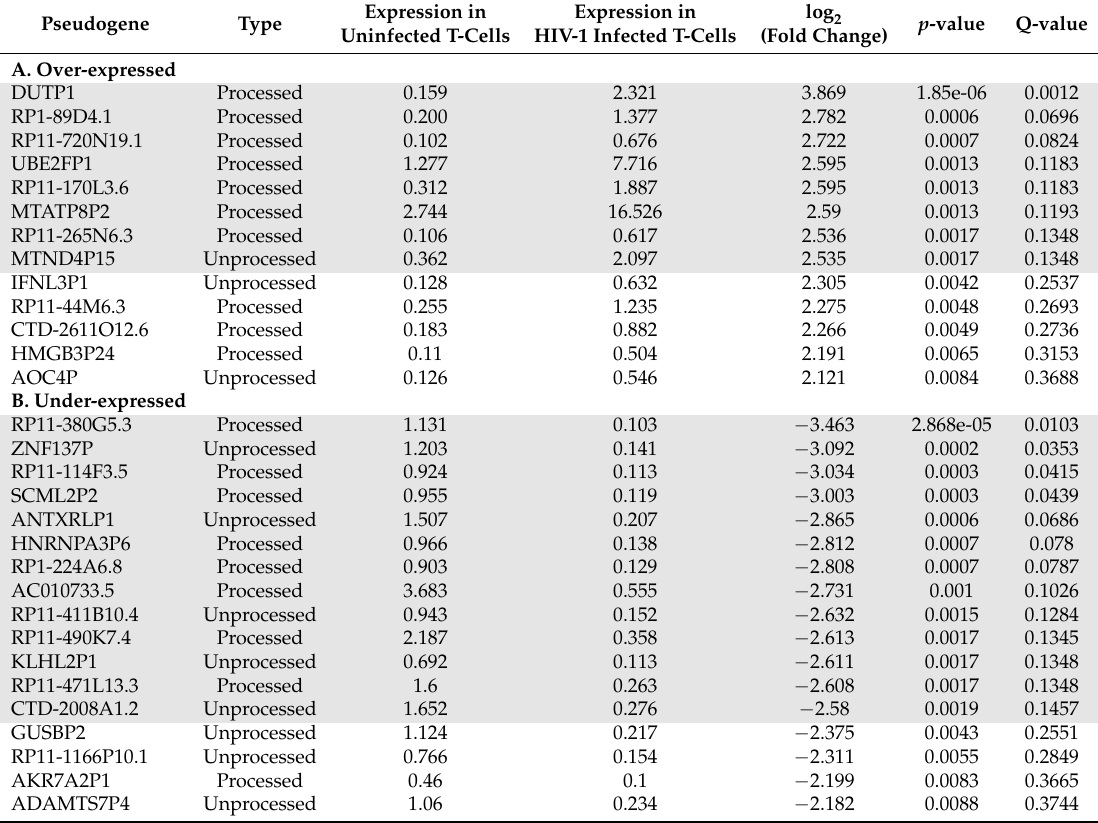
Table 1. Differentially-expressed pseudogenes in HIV-1 infection 7 days post-infection. Pseudogene expression is measured from RNASeq data as fragments per kilobase of transcript per million mapped reads (FPKM). Pseudogenes with a p -value < 0.01 and FDR < 0.25 are shaded and are deemed differentially